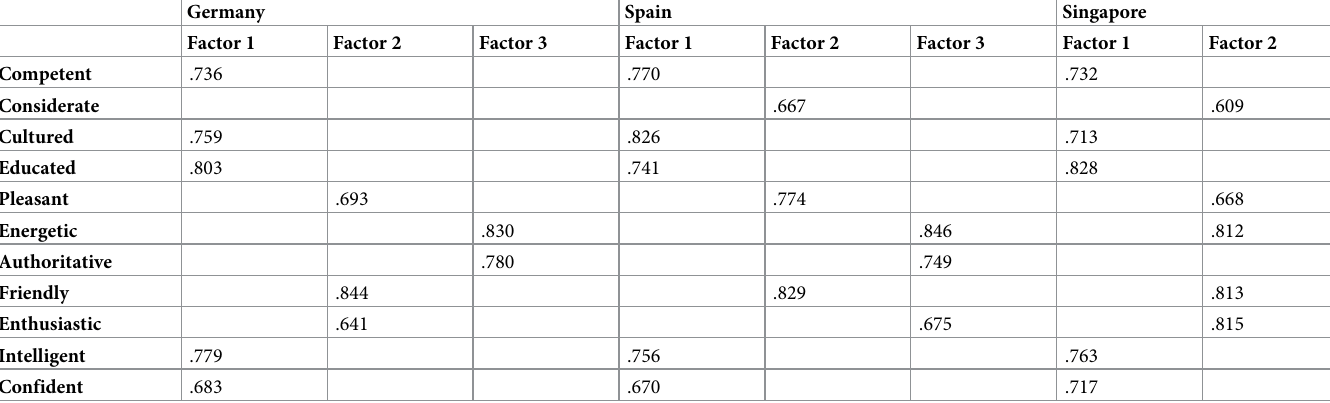
Table 3. Rotated Factor Matrix: Factor loadings scores on 11 scales with three factors for listener groups (Germany, Spain, Singapore). Only loadings > .550 are